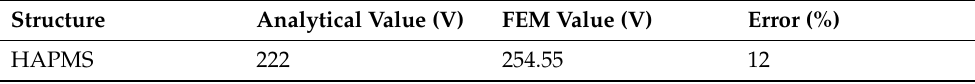
Table 8. Comparison of analytical values by the FEM of back EMF